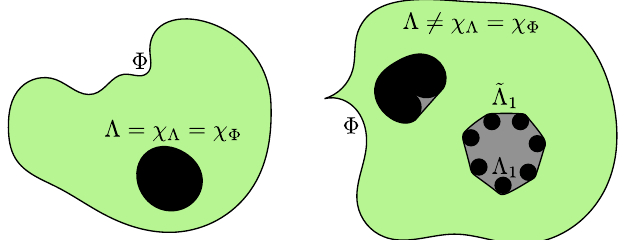
FIG. 3. Necessary condition χ Λ ¼ Λ for the interior boundary of a Riemannian manifold B to be identified as a logical system. In both diagrams, the physical Hilbert space H resides on the exterior boundary Φ of B , and Λ is the boundary of the punctures in the bulk, which are shaded in black. The green region is the entanglement wedge E ½ Φ (cid:2) , bounded by Φ and the minimal surface χ Φ ¼ χ Λ separating Φ from Λ ; the gray region is B n E ½ Φ (cid:2) . For purposes of illustration, we assume the bulk metric is Euclidean. On the left, we have χ Λ ¼ Λ , and the interpretation of Λ as a logical system is consistent. On the right, we have χ ≠ Λ , and two possible reasons for this are illustrated. First, Λ a connected component of Λ may fail to be convex. Second, the union Λ 1 of several connected components of Λ may be ~ Λ Λ encapsulated by a surface 1 with smaller area than 1 , in which ~ Λ Λ case the logical system resides on 1 rather than 1 . The emergence of this new logical system is reminiscent of the merging of small black holes to form a larger black